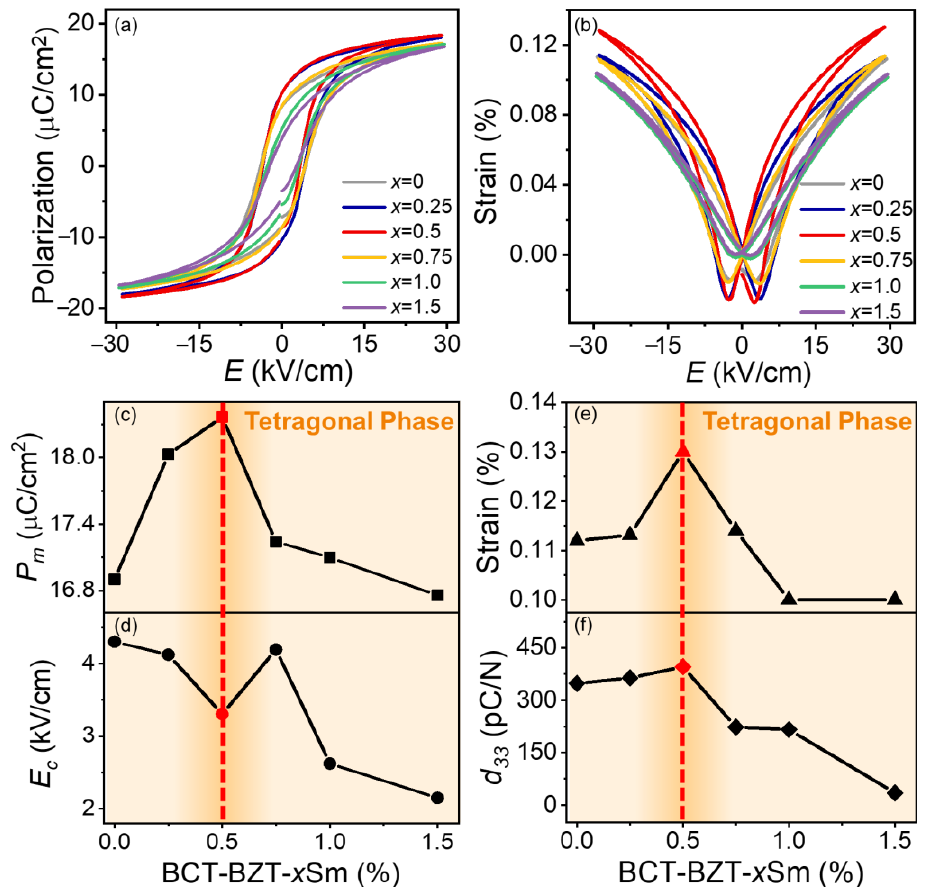
Figure 3. ( a ) Polarization - electric field loops and ( b ) electrostrain loops of the BCZT- x Sm ( x = 0, 0.25, 0.5, 0.75, 1, and 1.5) ceramics; composition-dependent ( c ) maximum polarization ( P m ), ( d ) coercive field ( E C ), ( e ) strain, and ( f ) piezoelectric coefficient ( d 33 ) curves measured in the tetragonal-phase region.